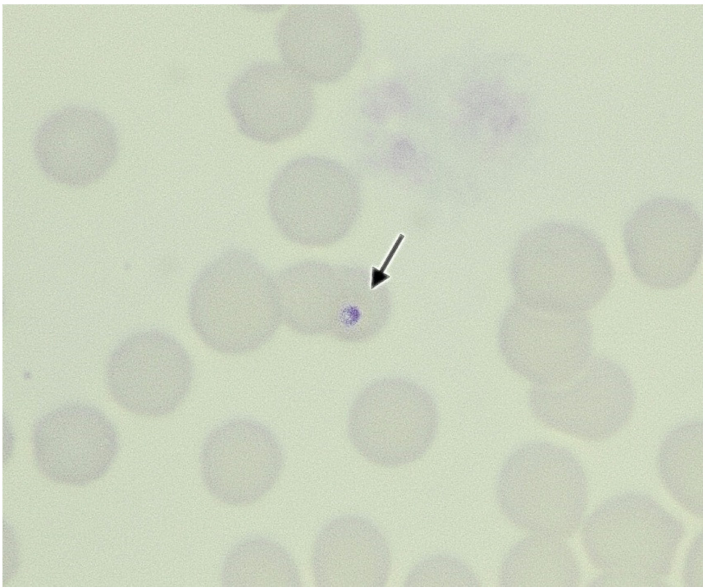
Figure 1. Stained blood smear showing a merozoite (arrow) within an erythrocyte in a domestic cat in central Italy. May–Grunwald–Giemsa stain, magnification of 100 ×